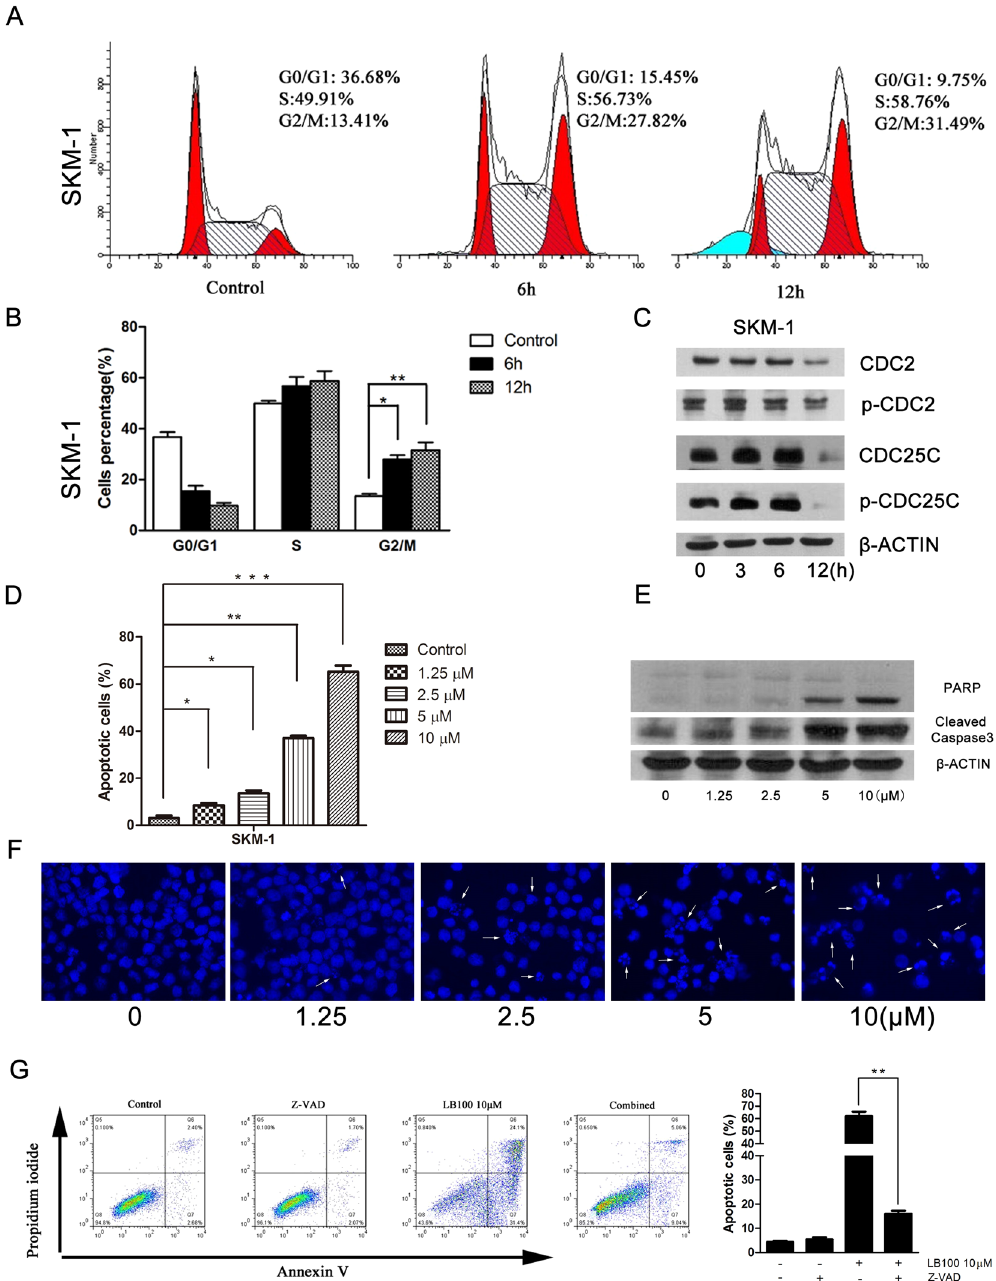
Figure 2. Analysis of cell cycle changes and apoptosis after LB100 treatment. ( A , B ) Flow cytometry analysis was performed to determine the relative percentage of SKM-1 cells in various phases of the cell cycle after 5 μ M LB100 treatment for 0, 6 and 12 h. Quantification of data demonstrates a time-dependent shift towards G2/M phase. ( C ) SKM-1 cells displayed a time-dependent decrease in G2/M regulatory proteins after 5 μ M LB100 treatment. ( D ) Flow cytometry analysis of SKM-1 cells stained with annexin V and propidium iodide demonstrated LB100 induced apoptosis in a concentration-dependent manner. ( E ) SKM-1 cells displayed a dose dependent increase in cleaved caspase 3 and PARP after 24 h exposure to LB100. ( F ) Fluorescent microscopy of Hoechst-stained SKM-1 cells demonstrated an increased amount of condensed and/or fragmented nuclei after progressively high doses of LB100. ( G ) Flow cytometry analysis was performed to quantify the proportion of apoptotic cells after 24 h of LB100 treatment (10 μ M) or control, in the presence or absence of z-VAD-FMK. z-VAD-FMK rescued cells from LB100-induced cell death, demonstrating a caspase-dependent mechanism of LB100-mediated cytotoxicity. Statistically significant differences are marked by an asterisk ( * P < 0.05; ** P < 0.01, *** P ≤